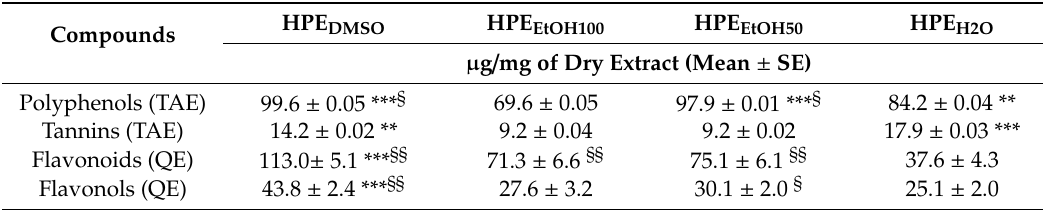
Table 2. Amounts of total polyphenols, tannins, flavonoids, and flavonols in the extract from Harpagophytum procumbens root (HPE) dissolved in DMSO (HPE DMSO ), 100% v / v EtOH (HPE EtOH100 ), 50% v / v EtOH (HPE EtOH50 ), and deionized water (HPE H2O ). Data are the mean ± SE of at least three independent experiments with three replicates for each experiment (n = 9).